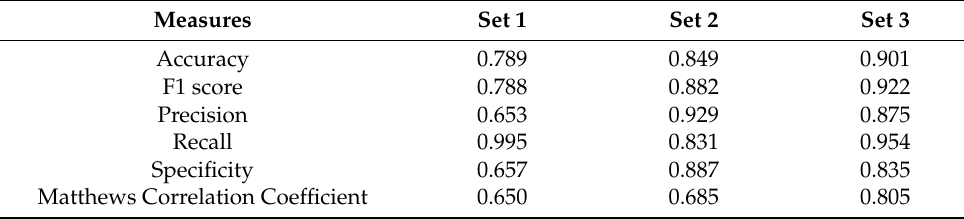
Table 5. Effectivity of Decision Tree models for recognition of troll users in online